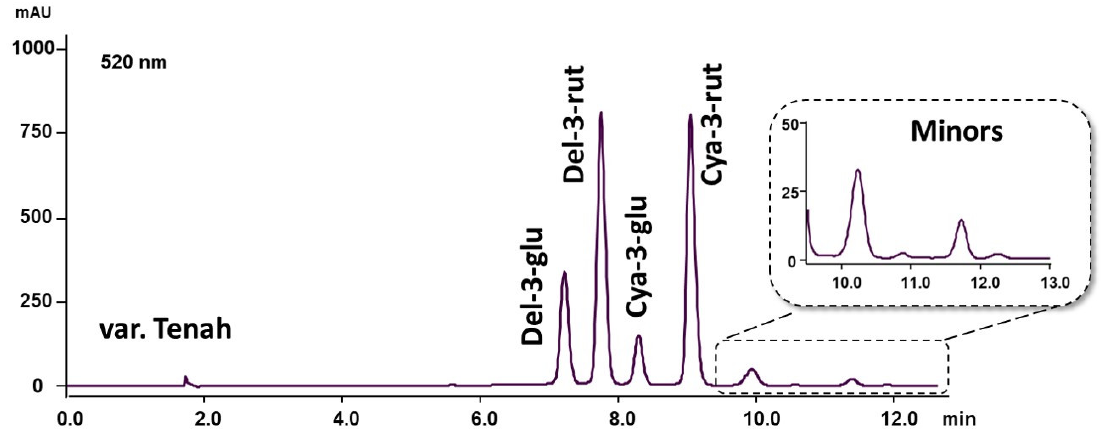
Figure 2. Chromatogram of major and minor anthocyanins in blackcurrant cultivar ‘Tenah’.